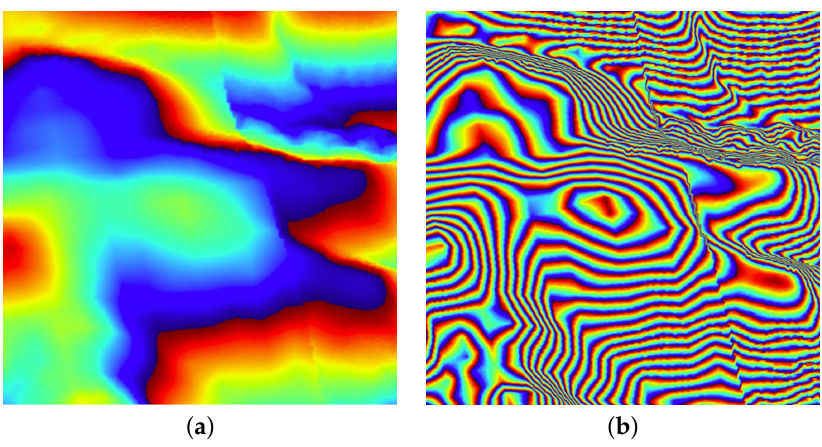
Figure 1. Example of synthetic topographic wrapped phase obtained using two different acquisition geometries: ( a ) small baseline; ( b ) large